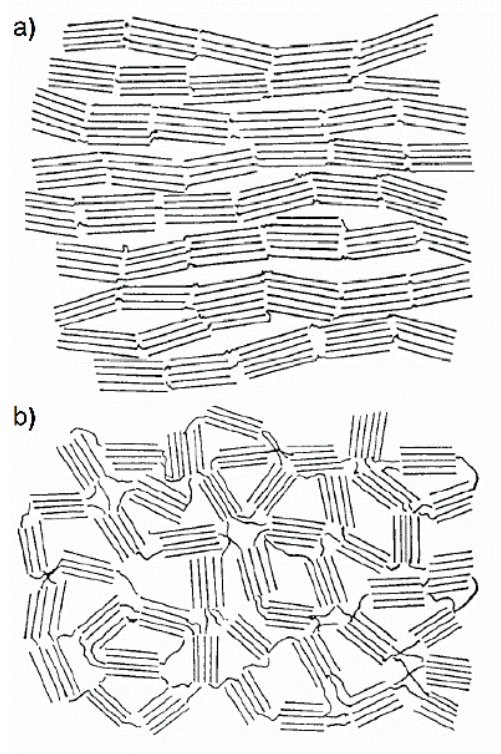
Figure 12. ( a ) Franklin’s representations of graphitising and ( b ) non-graphitising carbons. Reproduced with permission from Franklin [21]. Copyright The Royal Society, 1951.